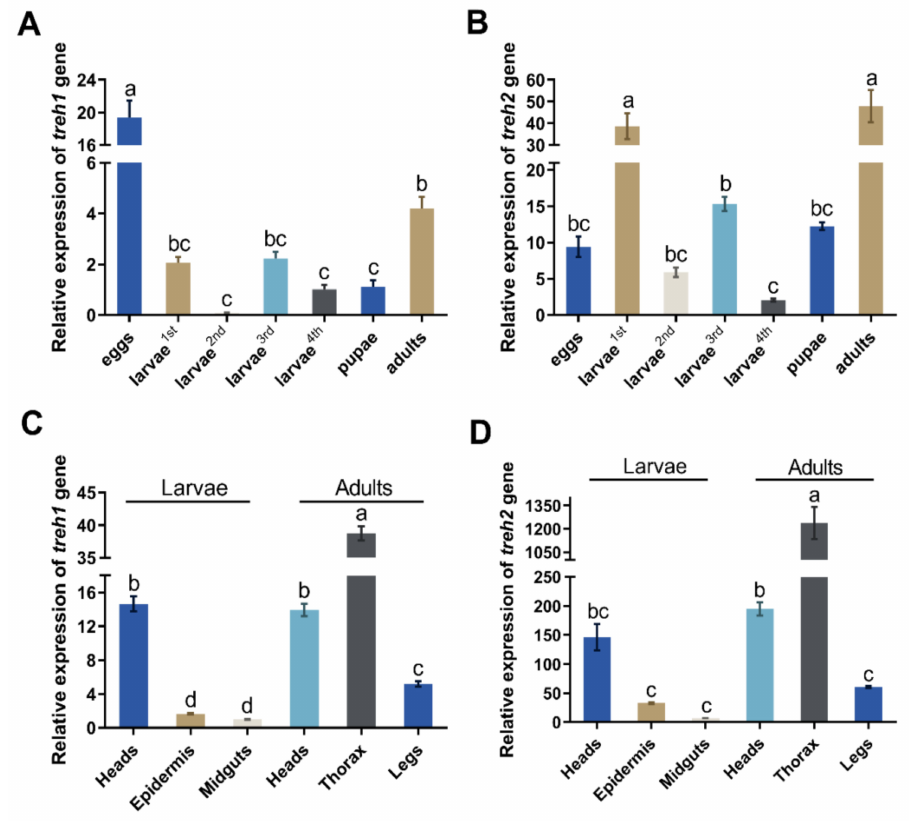
Figure 2. The relative expression (mean ± SE) of Treh 1 and Treh 2 in Plutella xylostella . ( A ) Expression of the Pxtreh 1 genes in different development stages (first to fourth larvae, pupae, adults, and eggs). ( B ) The expression of Pxtreh 2 genes in different developmental stages (first to fourth larvae, pupae, adults, and eggs). ( C ) The expression of Pxtreh 1 in different tissues (the heads, epidermises, and midguts of the fourth-instar larvae and the heads, thoraxes, and legs of the adults). ( D ) The expression of Pxtreh 2 in different tissues (the heads, epidermises, and midguts of the fourth-instar larvae and the heads, thoraxes, and legs of the adults). Pxtreh 1 expression in the midguts of the fourth larvae was used as the control. Data are expressed as a mean of three independent experiments ( n = 3). Endogenous EF1 was used as the internal control. Values with the same letter are significantly different at p < 0.05 (Tukey’s honest significance test). SE, standard